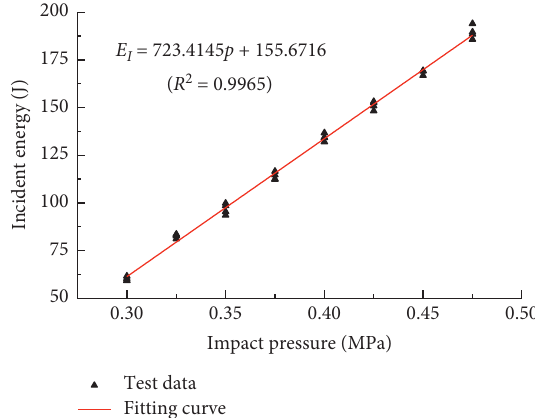
Figure 11: The relationship between incident energy and impact